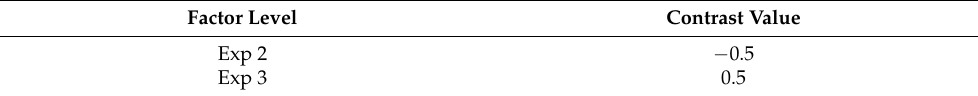
Table A21. Contrasts for Experiment factor.